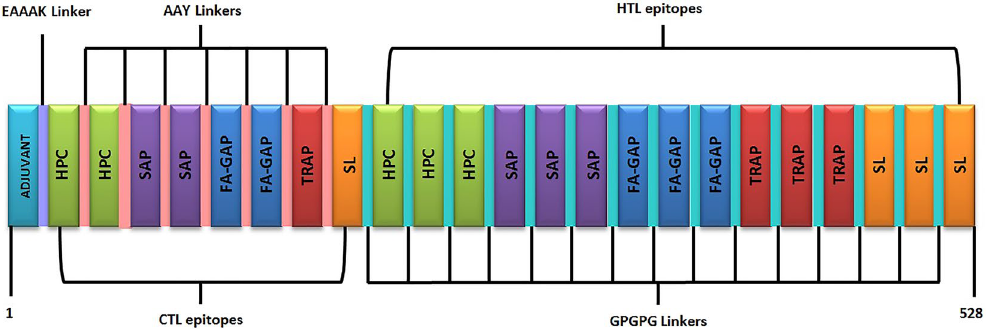
Figure 1. Schematic diagram of final subunit vaccine construct. The multi-epitope vaccine sequence consisting of 528 amino acid residues; out of which, first 130 residues has been represented as adjuvant followed by CTL (131–228 amino acids) and HTL (229–528 amino acids) epitopes. Adjuvant and CTL epitope has been joined by EAAAK linker (Light purple). Whereas, AAY (pink) and GPGPG (cyan) linkers were used to join the CTL and HTL epitopes, respectively. (HPC = Hypothetical protein conserved; SAP = Surface antigen protein; FA- GAP = FA-GAP repeat protein; TRAP = Translocon-associated protein; SL = Secretory lipase).